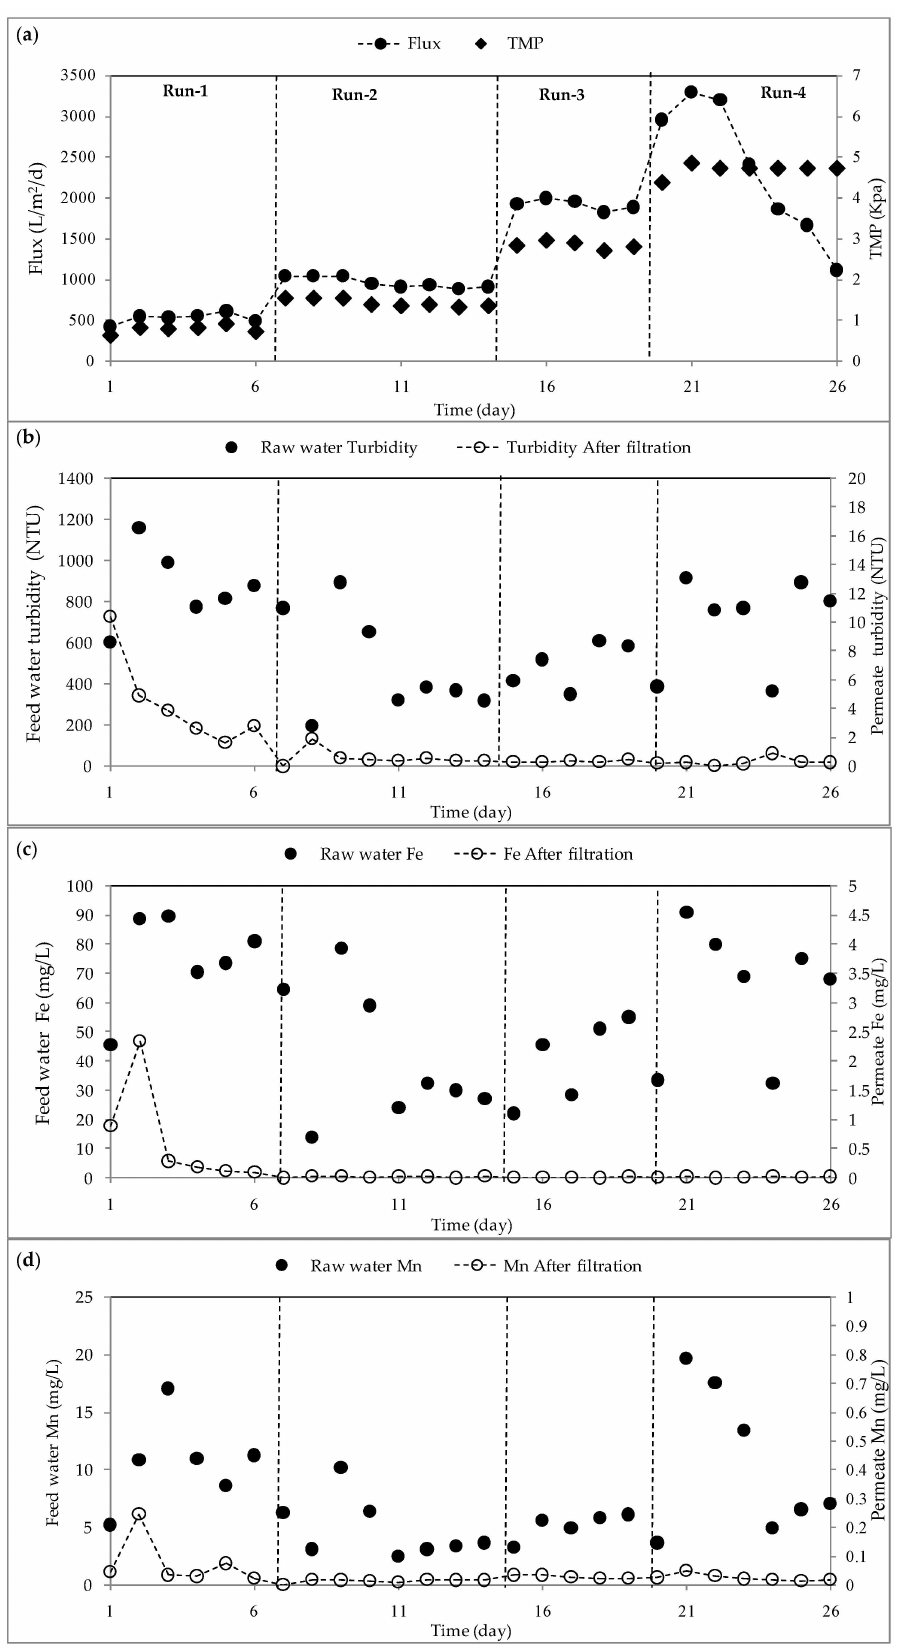
Figure 5. Continuous filtration experiments of 4 runs at different TMP: ( a ) variation of flux with TMP; ( b ) Turbidity in feed water and in thepermeate; ( c ) Fe in feed water and in the permeate, and ( d ) Mn in feed water and in the